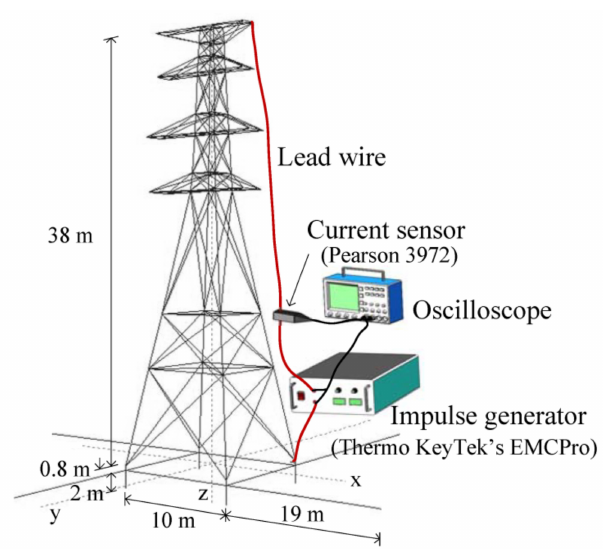
Figure 4. Layout of the tower and the grounding device under